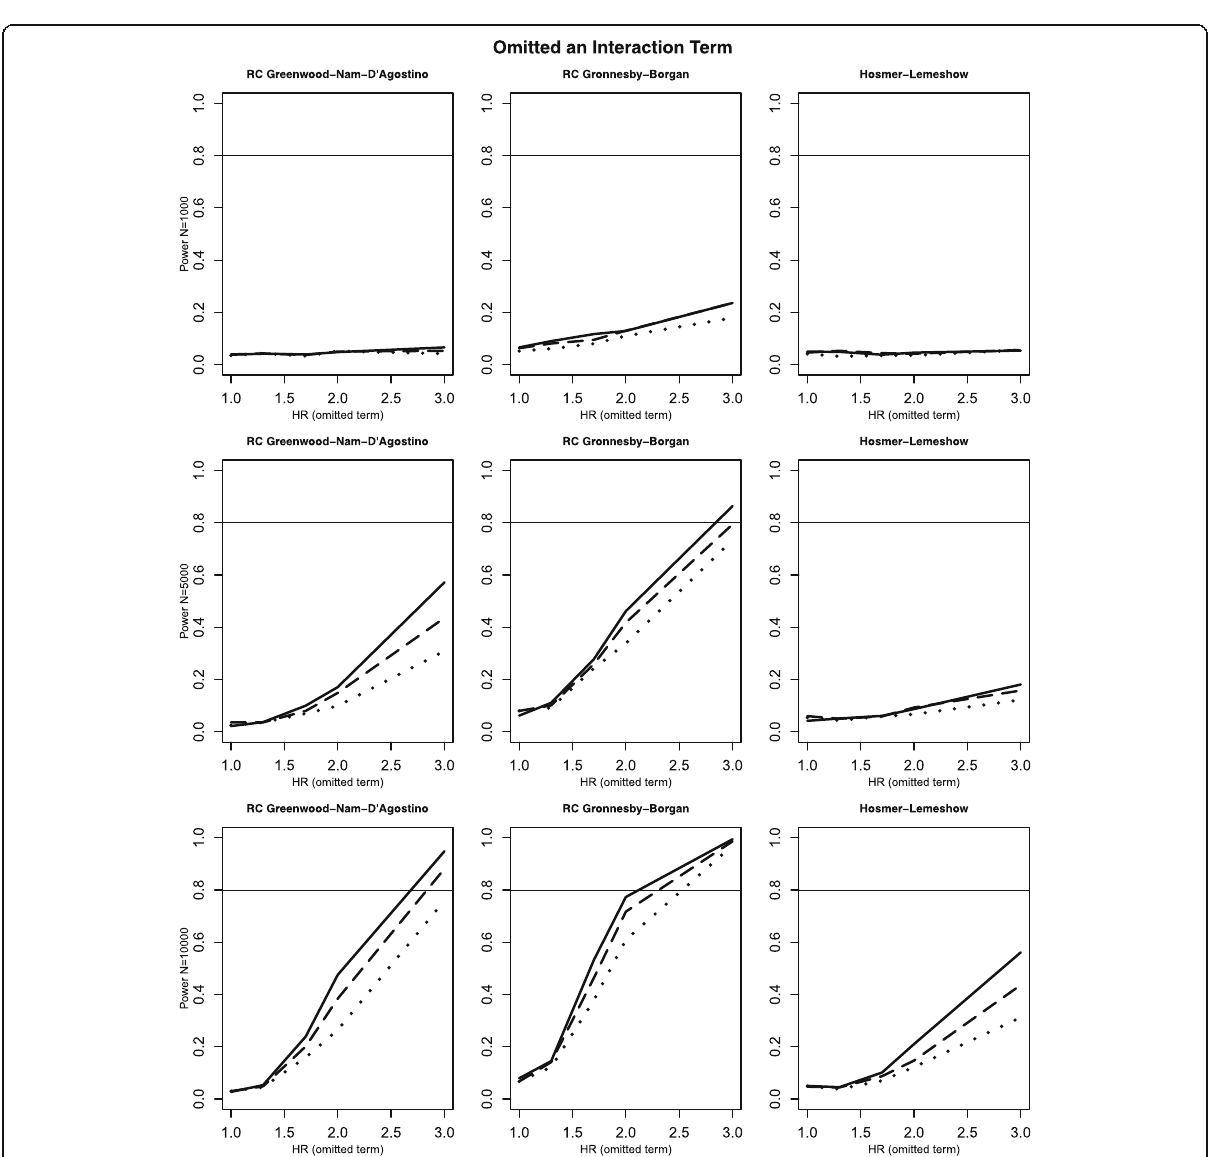
Fig. 5 Power when an interaction term is omitted for 0, 25, and 50% censoring rates. The RC and HL statistics were calculated for the following reduced and full models: y ~ x 1 and y ~ x 1 + x 2 ; y ~ x 1 and y ~ x 1 + x 12 ; and y ~ x 1 + x 2 and y ~ x 1 + x 2 + x 1 * x 2 . Data were simulated according to the full model, but the reduced model was used to estimate the expected proportions in the RC statistic formula. Left column — power of the RC-GND test, right column — power of the HL gof test. N = 1000 (top row), 5000 (middle row), 10,000 (bottom row), p = 0.1, collapse when ev g <